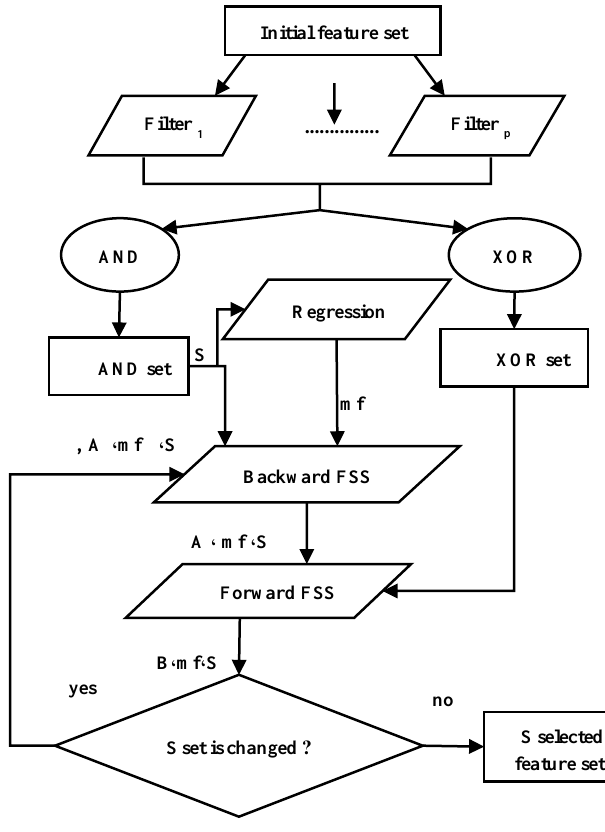
Figure 4. Flowchart of proposed method.